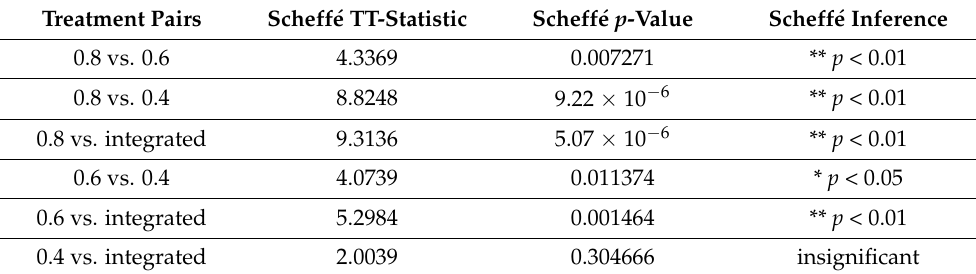
Table 10. Scheff é multiple comparison analysis results from phosphates datasets.